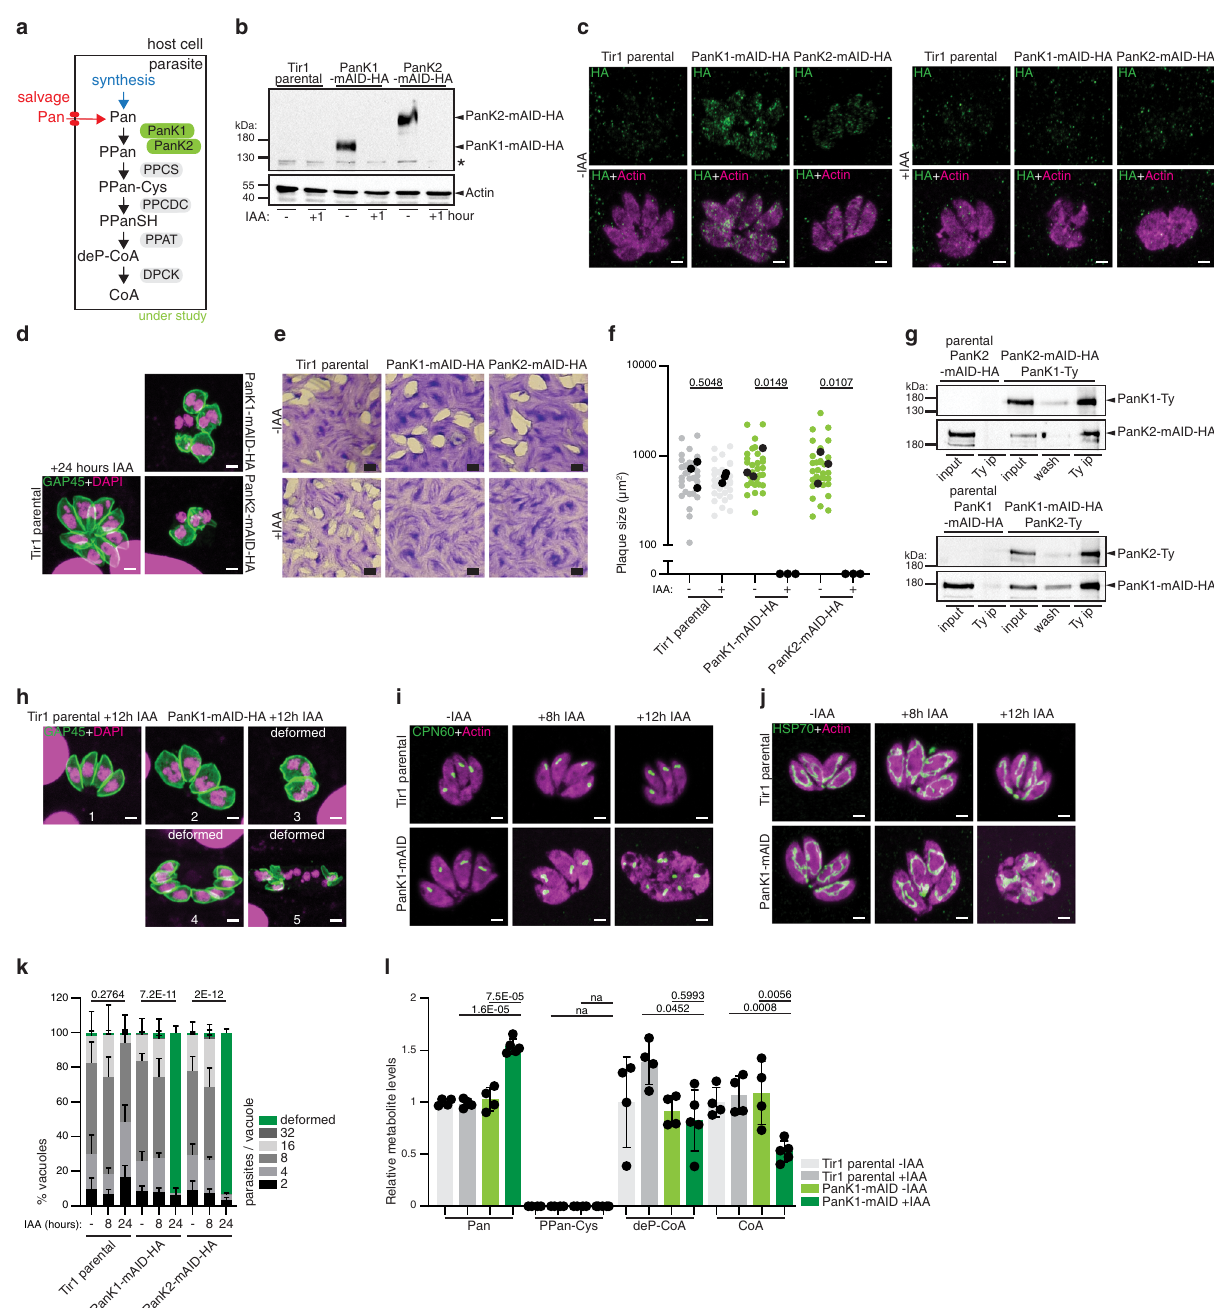
Fig. 2 Initiation of CoA biosynthesis from Pan is essential for T. gondii and relies on a heteromeric PanK-complex. a Scheme of the CoA biosynthesis pathway, highlighting the T. gondii pantothenate kinases (PanKs). See Fig. 1 for abbreviations of enzymes and metabolites. b Western blot of endogenous C-terminally mAID-HA tagged PanK1 and PanK2 (expected MW 144 kDa and 190 kDa, respectively) in presence of indole-3-acetic acid (IAA). Anti HA, anti actin as loading control ( n = 4). c Immuno fl uorescence assay (IFA) of PanK1-mAID-HA and PanK2-mAID-HA. Antibodies: anti HA and anti actin marking the parasite cytoplasm ( n = 5). d IFA of 24 h IAA treated PanK1- and PanK2-mAID-HA. Antibodies anti GAP45 for parasite pellicle, DAPI for nuclear staining ( n = 3). e Plaque assays of PanK1-mAID-HA and PanK2-mAID-HA in the presence of IAA ( n = 4). f Quanti fi cation of plaque size. Black dots present the average of each independent experiment. ( n = 3, 2-sided t -test). g Western blot of co-immunoprecipitation (IP) assay of dually tagged PanK1-Ty/PanK2-mAID-HA (top, n = 3) and PanK1-mAID-HA/PanK2-Ty (bottom, n = 4). Antibodies for IP: anti-Ty; anti-HA and anti-Ty for revelation. h IFA of PanK1-mAID-HA with IAA for 12 h. Antibodies: anti GAP45 for parasite pellicle, DAPI for nuclear staining ( n = 3). i , j IFAs of apicoplasts and mitochondria, respectively, at the indicated timepoints of IAA addition in PanK1-mAID-HA. Antibodies: anti actin for parasite cytoplasm, anti CPN60 for apicoplasts, anti HSP70 for mitochondria ( n = 3). k Intracellular growth assay of the PanK1- and PanK2-mAID-HA. Deformed parasites were scored as indicated in panel h ( n = 3 – 6, mean and SD, 2 tailed t -test on the “ deformed ” category). l LC-MS analysis of indicated metabolite abundances in PanK1 depleted parasites (8 h + IAA, n = 4 – 5, mean and SD, 2-sided Student ’ s t test). Equal number of parasites were analyzed, and metabolite levels normalized to an internal standard ( 13 C 6 / 15 N-isoleucine) and quanti fi ed relative to Tir1 parental − IAA (abundance = 1). n number of independent biological replicates. Source data are provided as a Source Data fi le. White scale bar 2 µ m, black scale bar 1 mm. Black asterisk indicates unspeci fi c signal. NATURE COMMUNICATIONS| (2022) 13:345